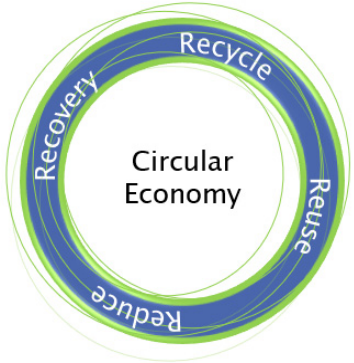
Figure 1. Circular economy’s four R’s.